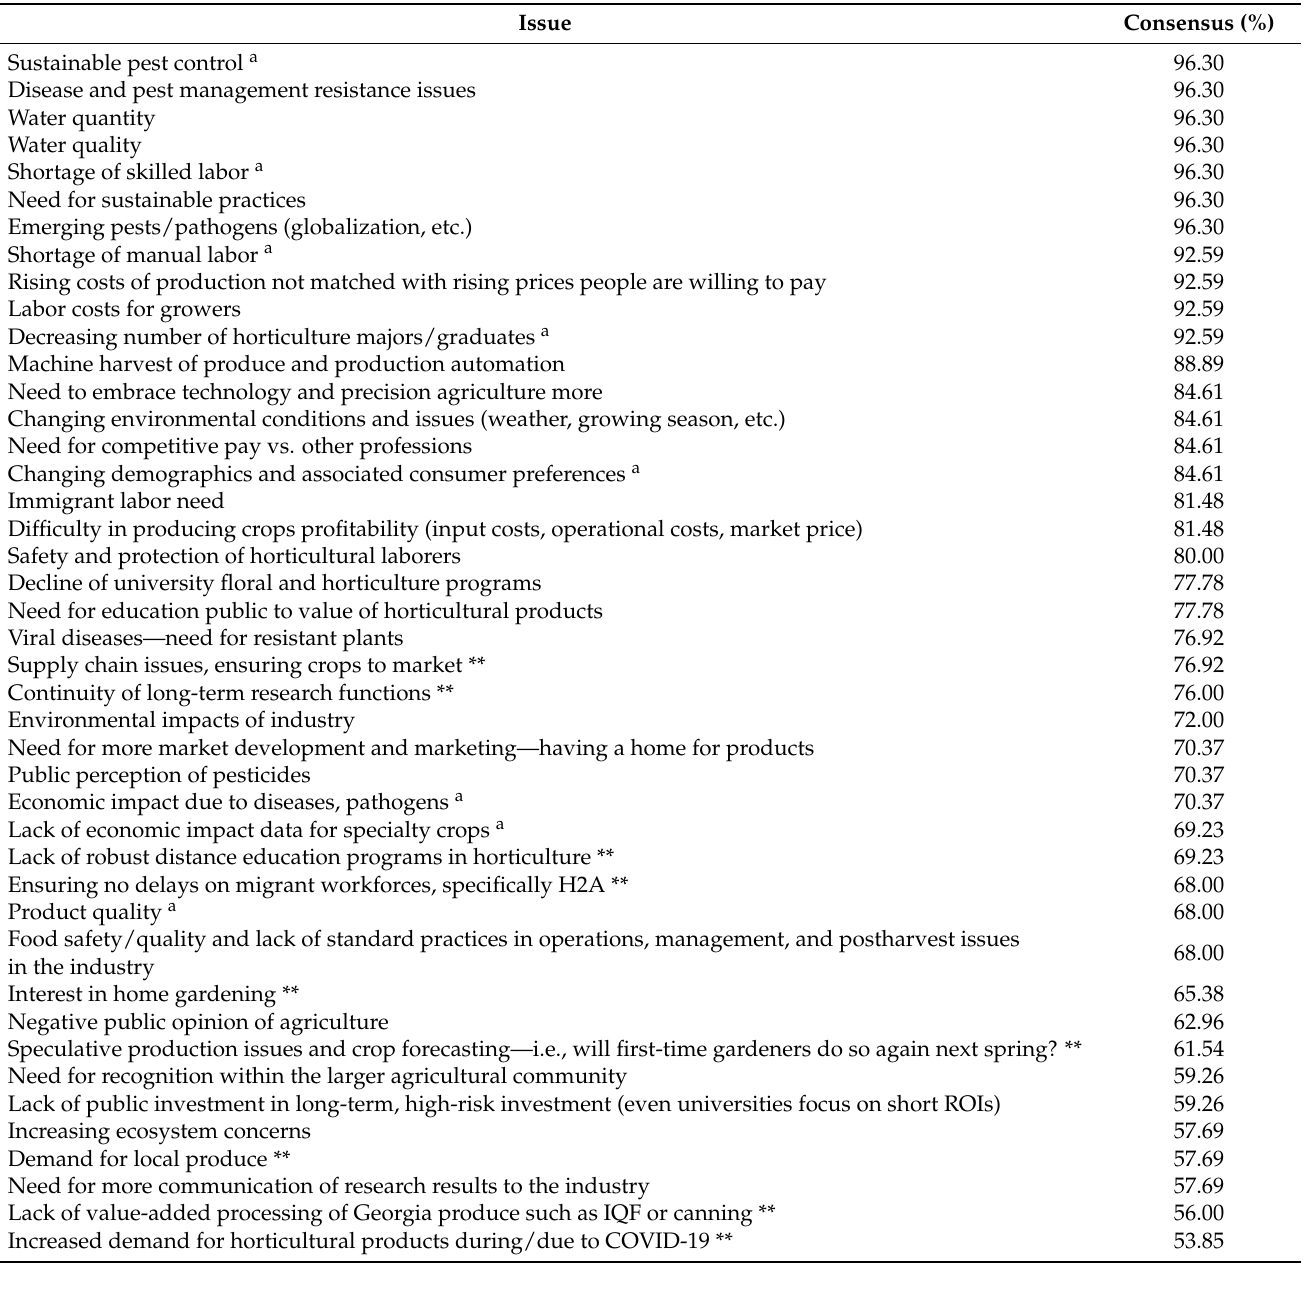
Table 3. Delphi round three results: level of consensus for critical issues facing industries related to horticulture ( n =